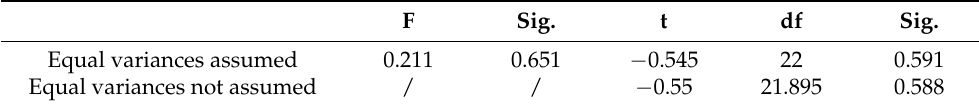
Figure 11. Electricity use intensity validation for a single agent [62]. Table 11. The results of independent sample test. Table 11. The results of independent sample